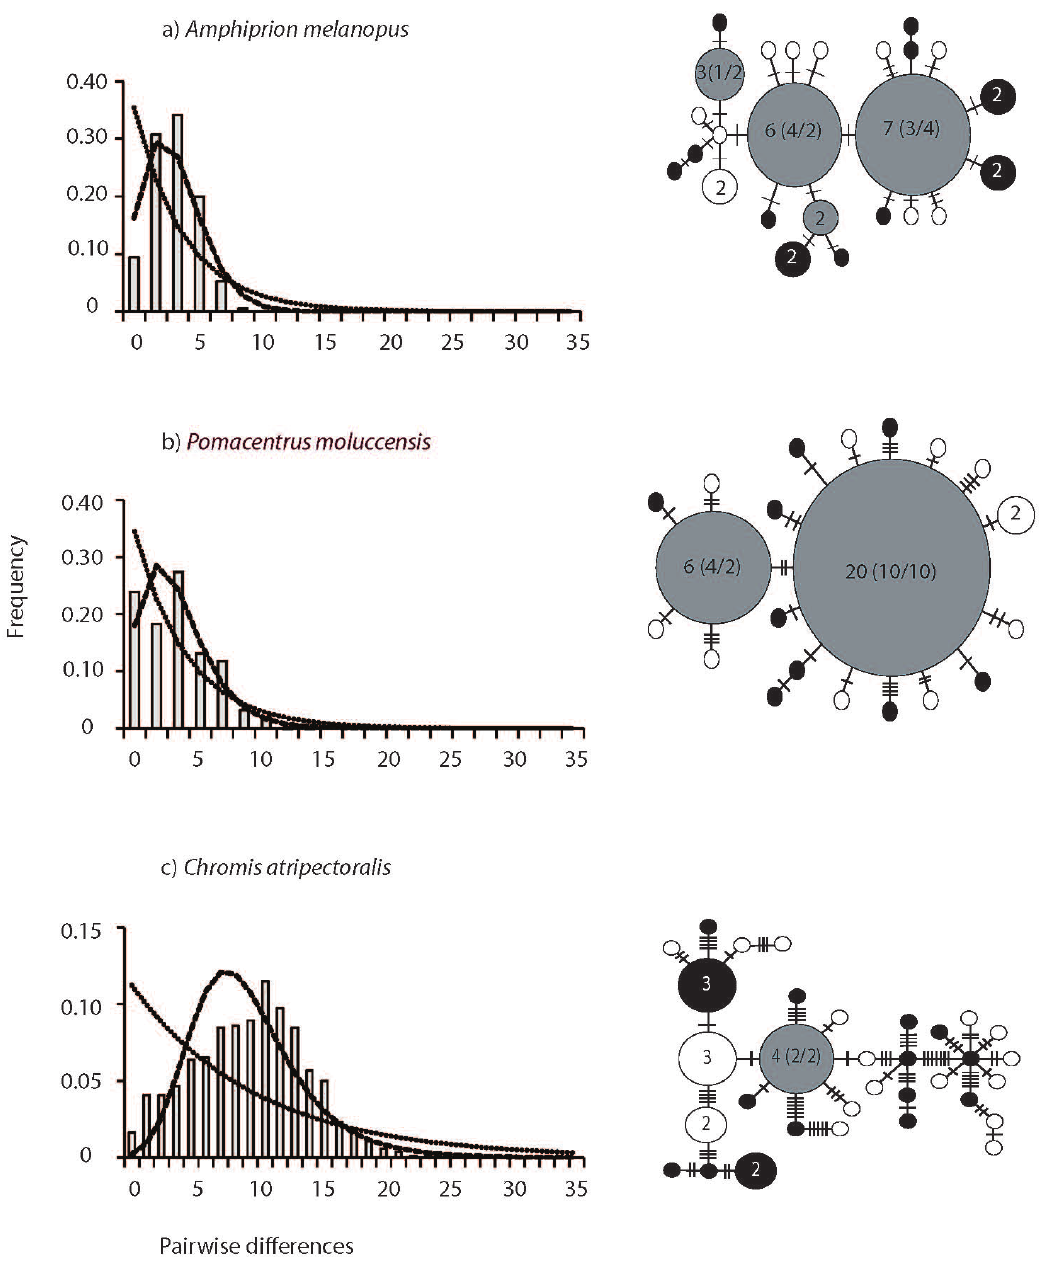
Figure 3. Distribution of pairwise genetic differences using mismatch frequencies and haplotype networks of (a) – (c) widespread species and (d) – (f) spatially restricted species. Haplotype distributions indicated in networks by circles where their size and the embedded number indicates its frequency and the location indicated by shading (grey = shared, none = LI or OI/black = OTI,). The number of mutations separating haplotypes are represented by dashes. The observed frequency of pairwise differences are shown by the grey bars, the expected distribution based on a constant population size is plotted by the dotted line and the expanding population is plotted by the dashed